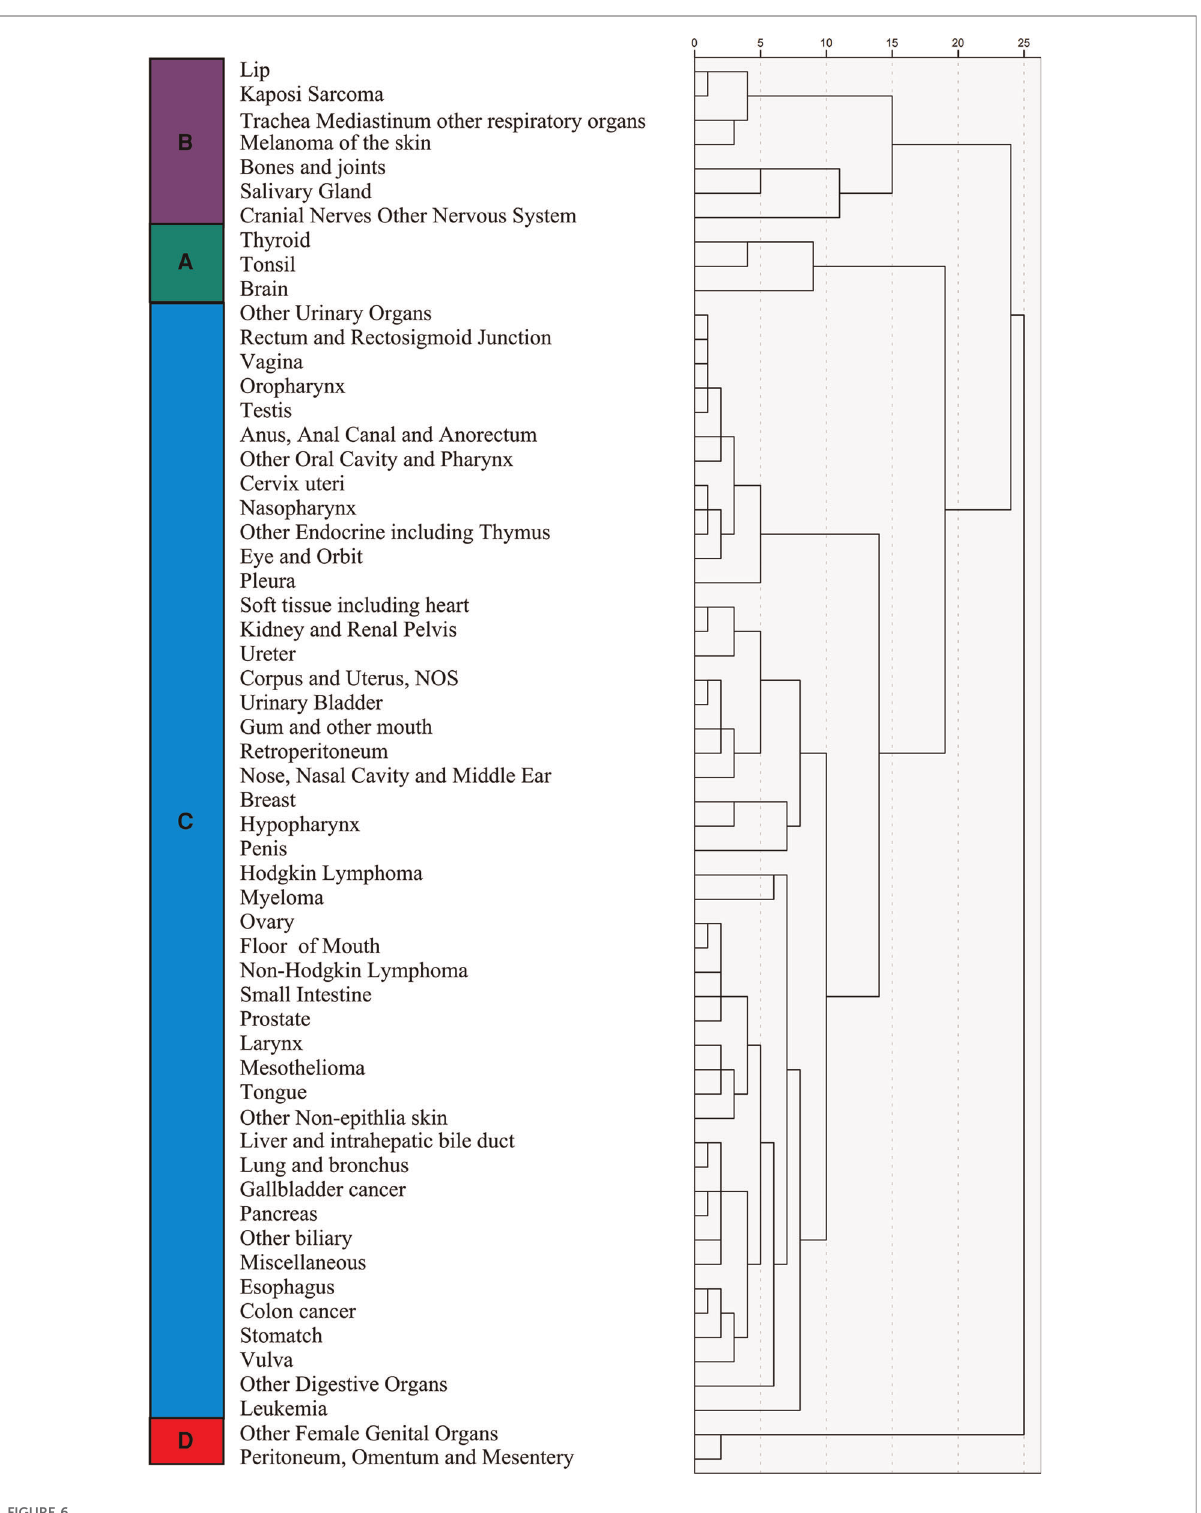
FIGURE 6 Unsupervised hierarchical cluster analysis for the classi fi cation of cancer types; the 58 cancer types are sub-grouped into four categories ( A – D